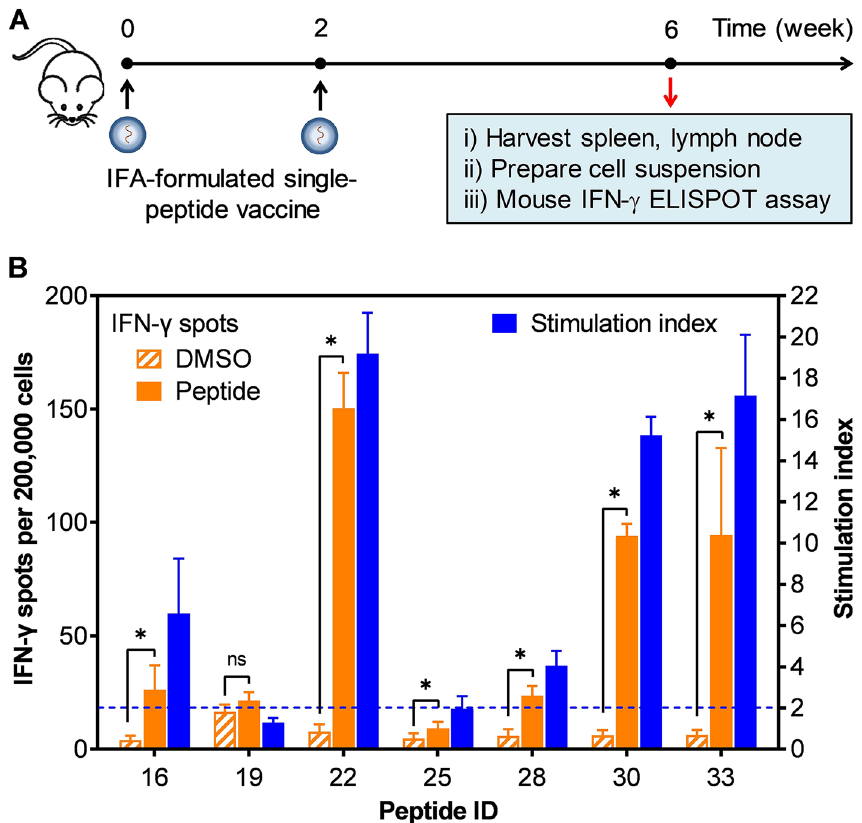
Figure 3. Evaluating immunogenicity of peptides in B6.Cg-A2 mice. ( A ) Each of seven selected individual peptides was formulated with IFA and injected into B6.Cg-A2 mice (n = 3). Four weeks after the booster vaccination, splenocytes and lymphocytes were isolated and used to evaluate the immunogenicity of individual peptides. ( B ) Isolated splenocytes and lymphocytes were stimulated with either DMSO (negative control) or corresponding peptides. The asterisks (*) indicate a significant difference ( p < 0.05) in IFN-γ spots induced by individual peptides over DMSO background. Positive responses were defined as those with the stimulation index ≥ 2 and p < 0.05. The dashed line represents a threshold of selection for fold change. Each experiment condition was replicated four times and data were presented as mean ± standard deviation